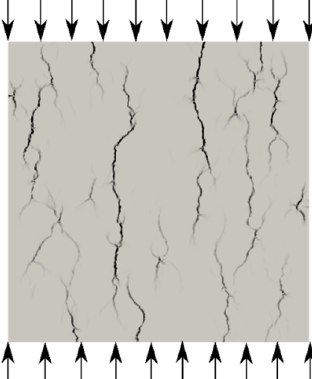
Figure 19. Damage map within an RVE under uniaxial compression load of 10 MPa. Arrows denote the loading